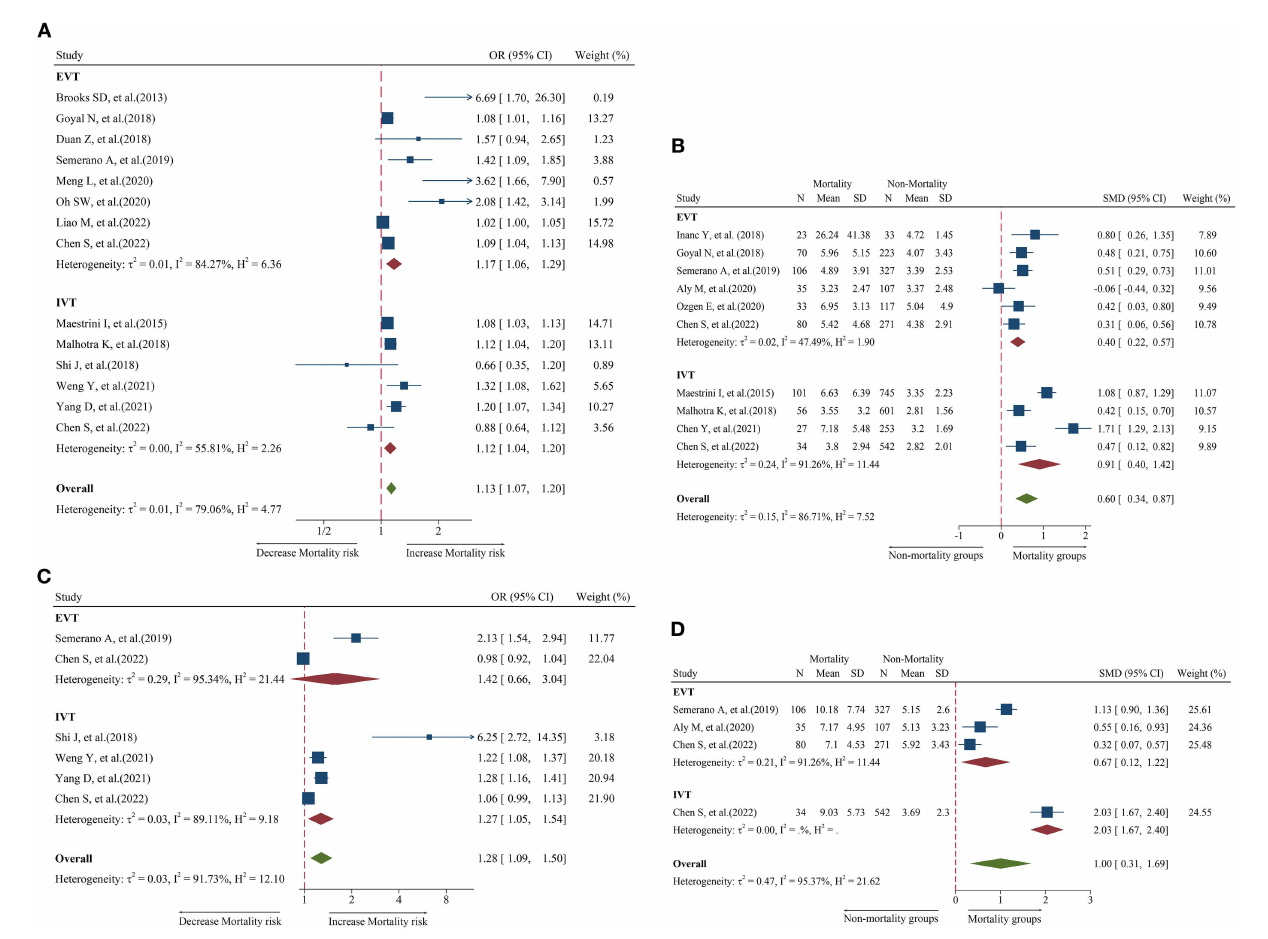
FIGURE4 Forest plot showing the association of NLR and 3-month mortality; (A) forest plot of admission NLR based on OR; (B) forest plot of admission NLR based on SMD; (C) forest plot of post-treatment NLR based on OR; and (D) forest plot of post-treatment NLR based on